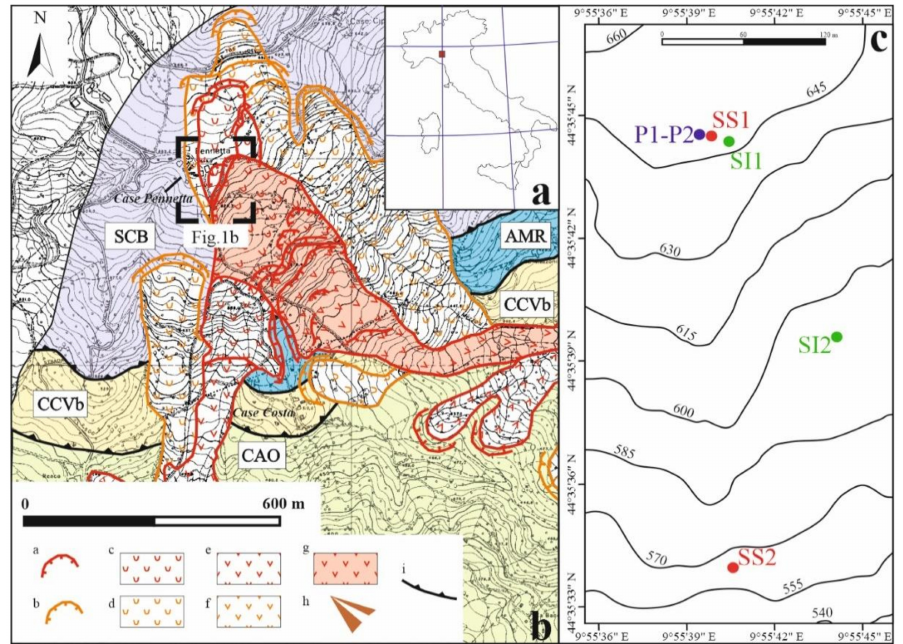
Figure 1. ( a ) Localization of the study area and ( b ) geological and geomorphological sketch map of the study area: (a) scarp of active landslide, (b) scarp of dormant landslide, (c) active landslide, (d) dormant landslide, (e) active earth flow, (f) dormant earth flow, (g) active earth slide / earth flow, (h) debris / earth flows cone with man interventions, and (i) main thrust. SCB: Arenarie di Scabiazza (sandstone); AMR: Argillle a Palombini di Monte Rizzone (clay stone); CCVb: Argille a blocchi (clay stone with blocks); CAO: Flysch of Monte Caio (marly-limestone). Base map: Technical Regional Map 1:5000, Emilia-Romagna Region 1998 (ed.) [29]. ( c ) Detailed topographic map with the location of boreholes (SI1–SI2), piezometers (P1–P2), and soil sample collection sites